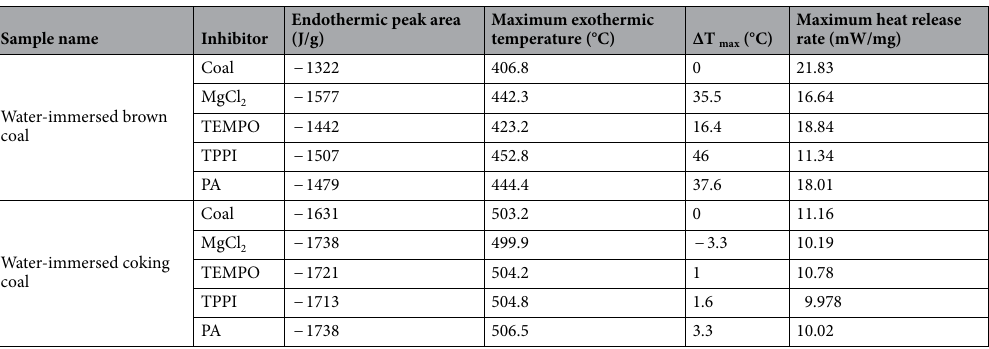
Table 6. Spontaneous combustion and exothermic parameters of water-immersed brown coal and water- immersed coking coal after adding